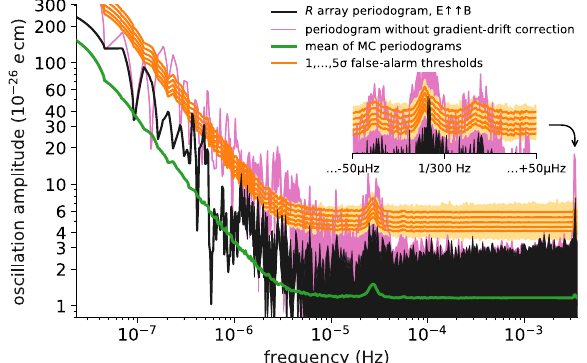
FIG. 3. Periodogram of the R time array of the PSI experiment data, sensitive to oscillations in the quantity d taken with the E and B fields parallel (black line). The mean of MC-generated periodograms, assuming no signal, is depicted in green. MC simulation is used to calculate 1 ; 2 ; … ; 5 σ false-alarm thresholds, depicted in light orange. For clarity, we also plot the smoothed version in orange. There are two regions where a rise in the amplitude is expected, namely, around 28 μ Hz (inverse of 10 h) and 3.3 mHz (inverse of 300 s), due to the time structure of the data taking (see the main text for more details). The periodogram of nongradient-drift-corrected data is shown in